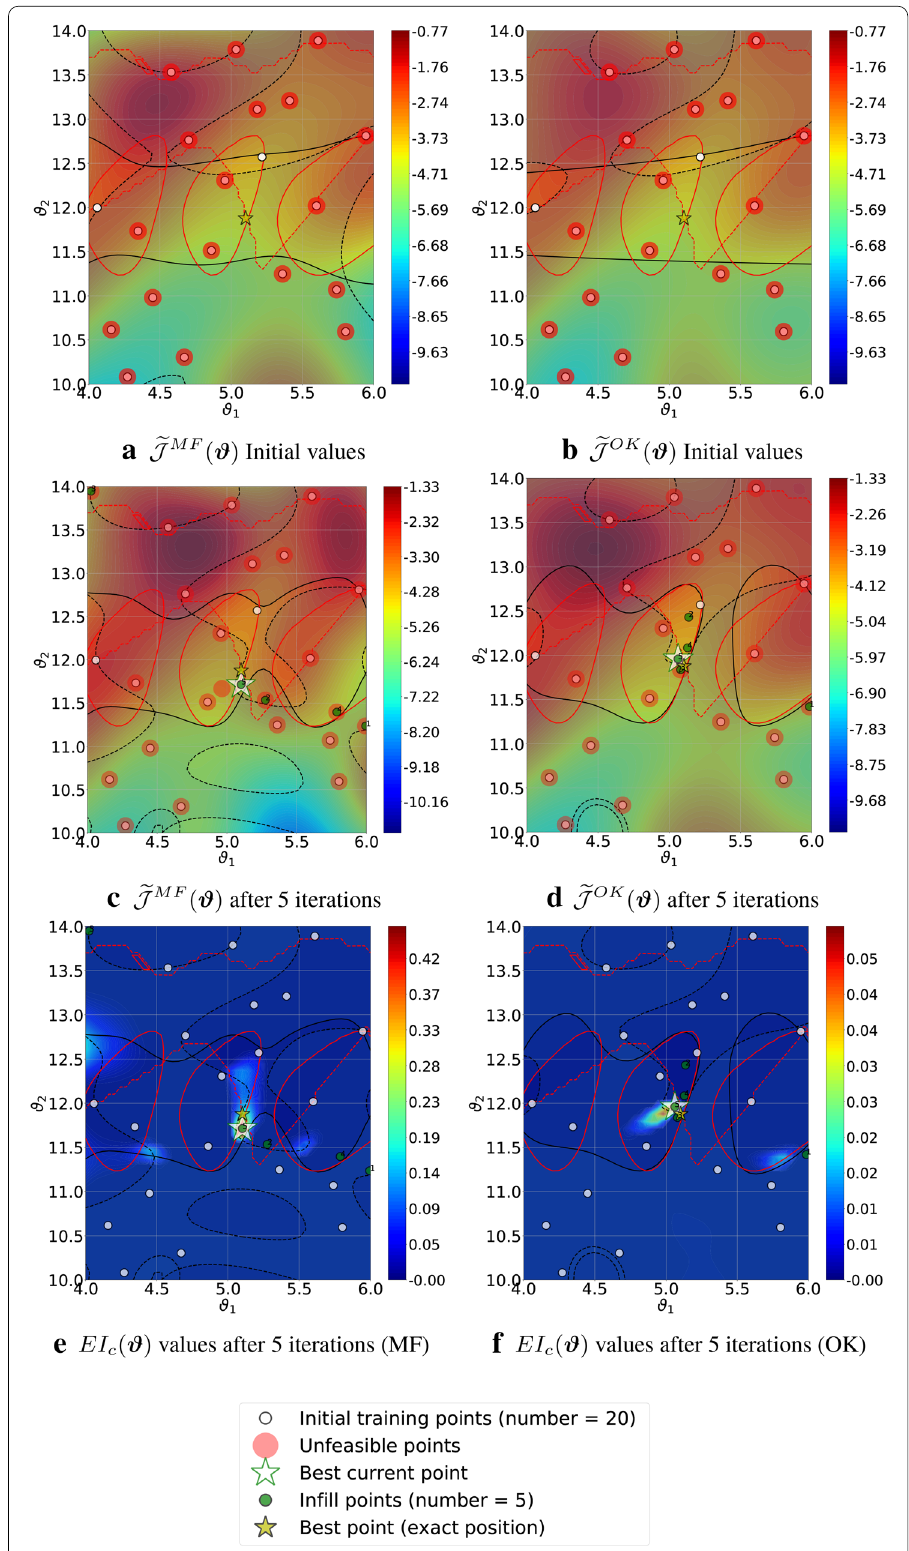
Fig. 8 Optimization results obtained using the EI c criterion. Starting from 20 points (first row), the algorithm is iterated for 5 iterations (the other